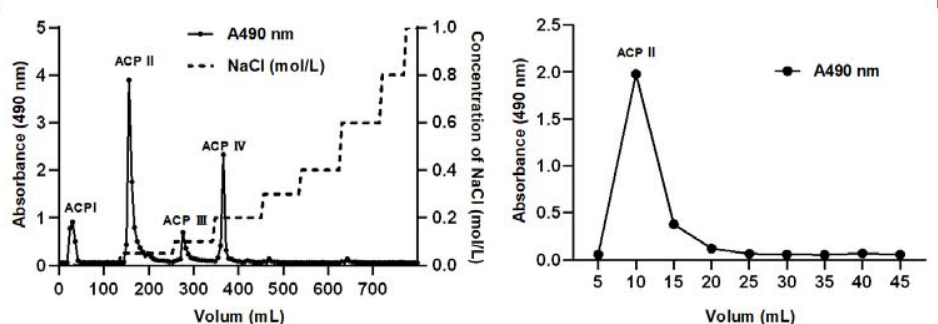
Figure 6. Fractionation of A. camphorata polysaccharides by ion-exchange chromatography and size- exclusion chromatography. Crude polysaccharides on HiTrap Q FF ( A ), and fraction II on Seuperdex 200 Increase 10/300 GL column ( B ). Table 4. Yield and content of polysaccharides and selenium of ACP I, ACP II, ACP III, and ACP IV.